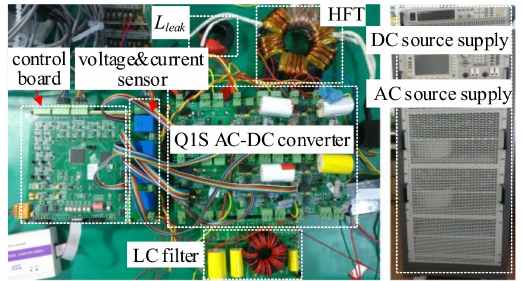
Figure 15. Photograph of experimental platform of Q1S AC-DC converter.